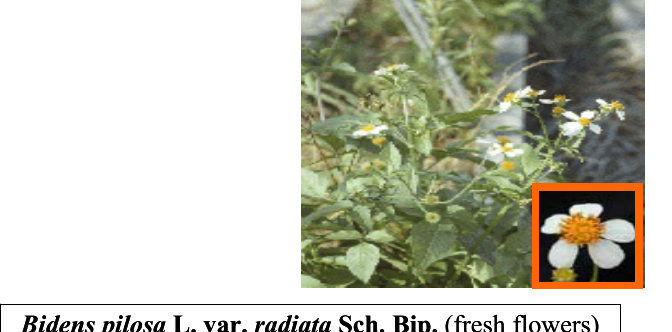
Figure 1. Flow chart of solvent extraction and liquid-liquid partition in different solvent polarity on flower part of Bidens pilosa L. var. radiata .